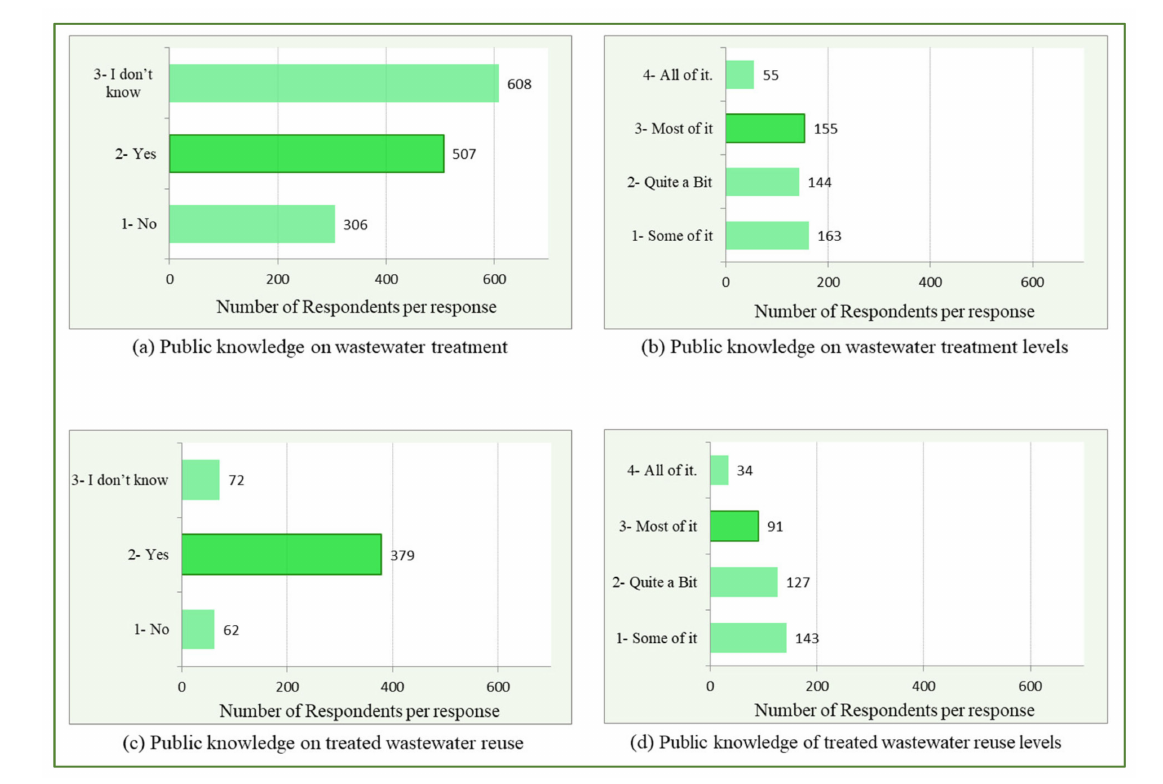
Figure 2. Public knowledge on wastewater treatment and reuse: ( a ) Public knowledge on wastewater treatment; ( b ) Public knowledge on wastewater treatment; ( c ) Public knowledge on treated wastewater reuse; ( d ) Public knowledge on treated wastewater reuse